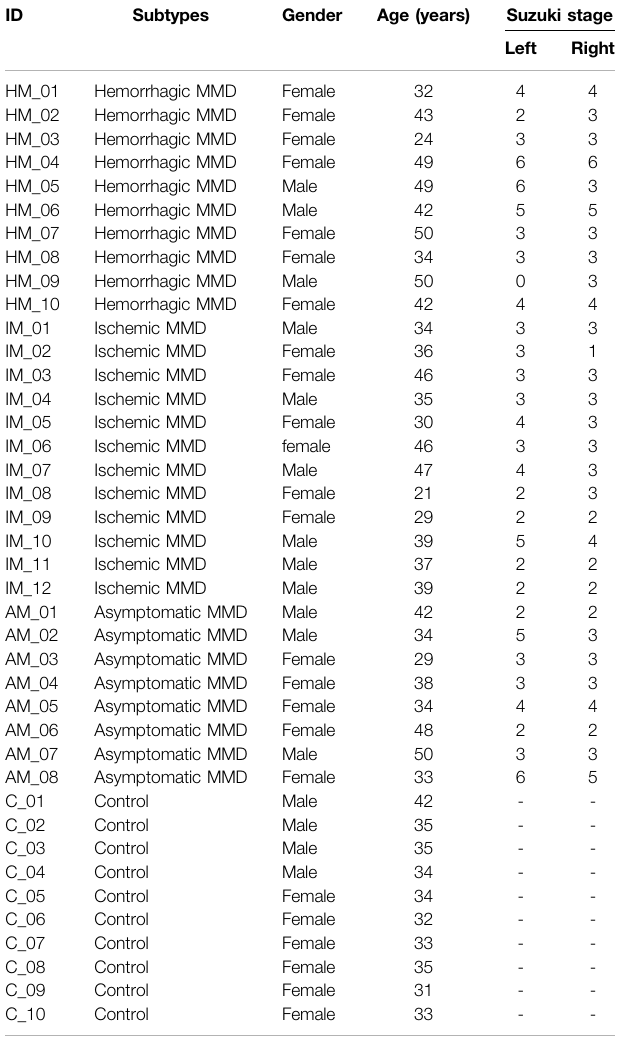
TABLE 1 | Demographic and clinical characteristics of the